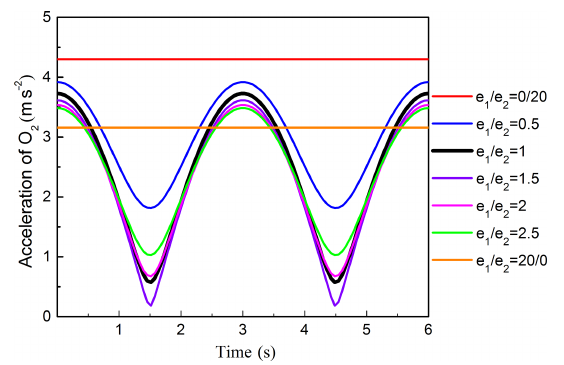
Figure 11. Effects of e 1 /e 2 on the acceleration when ω 1 (cid:54)= ω 2 and ω 1 · ω 2 > 0 ( e 1 + e 2 = 2 e ) ( ω 1 /ω 2 = 6 / 7).